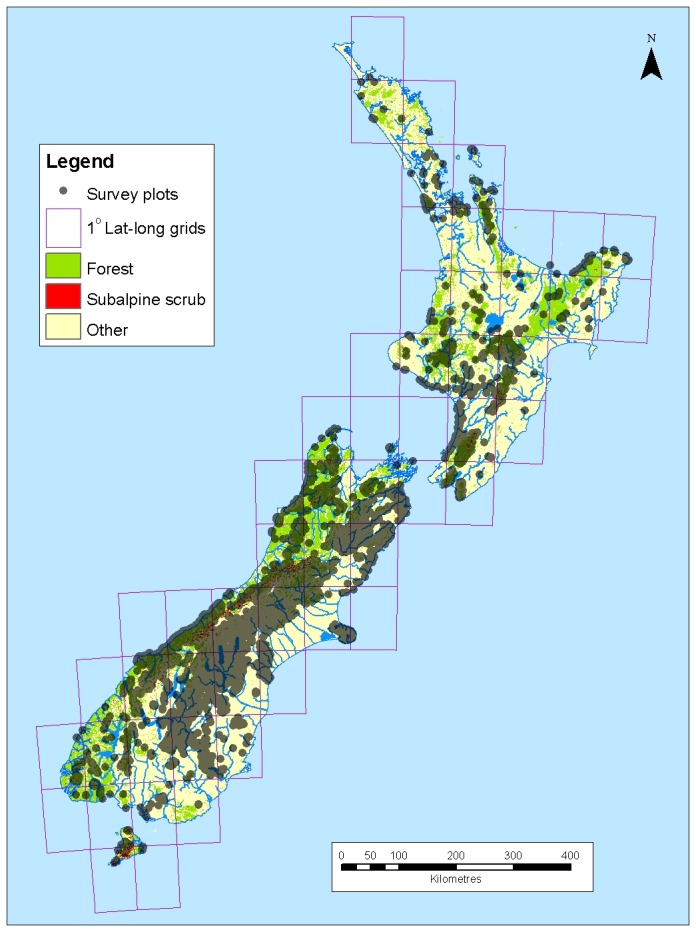
Map of survey plots used in boosted regression tree modeling.Vegetation classes for New Zealand survey plots are mapped based on a reclassification of Dymond and Shepherd [58]. ‘Other’ is all non-forest vegetation except subalpine scrub.